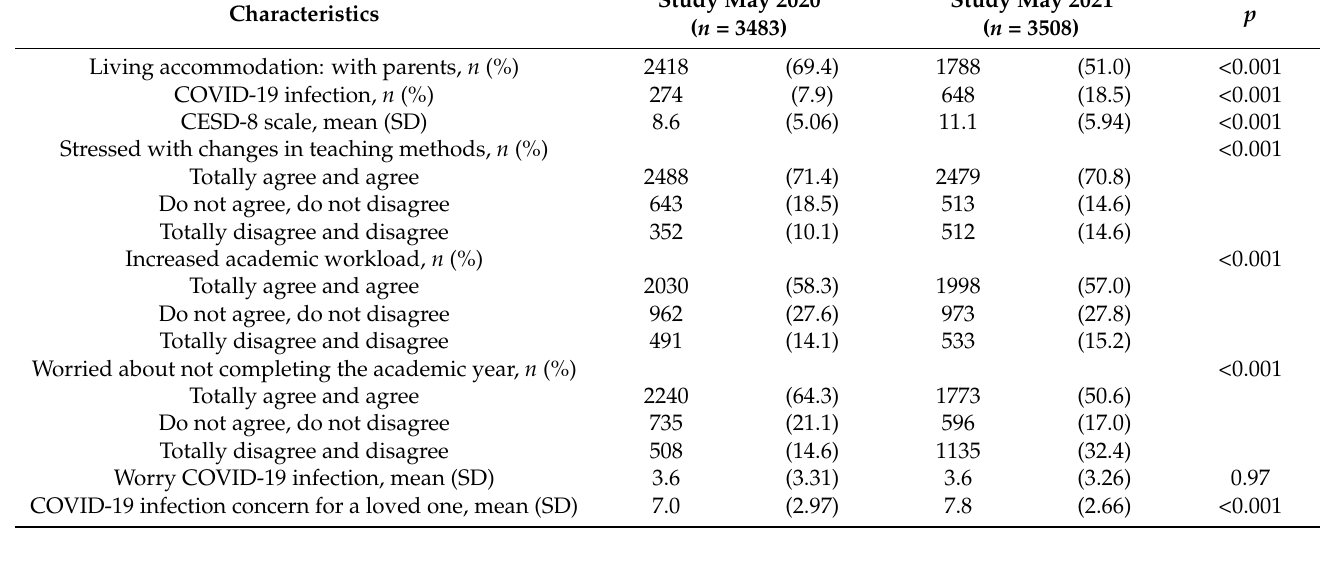
Table 1. Characteristics of the university students (Study May 2020 n = 3483; study May 2021 n = 3508). Characteristics